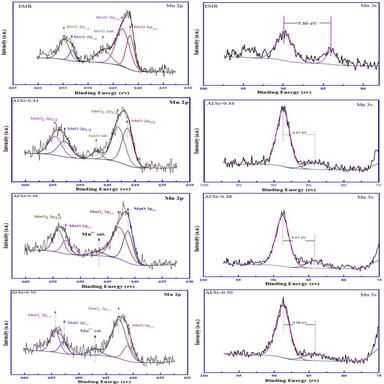
XPS fitting spectra of Mn2p and Mn3s in EMR and different Al/Si ratios.